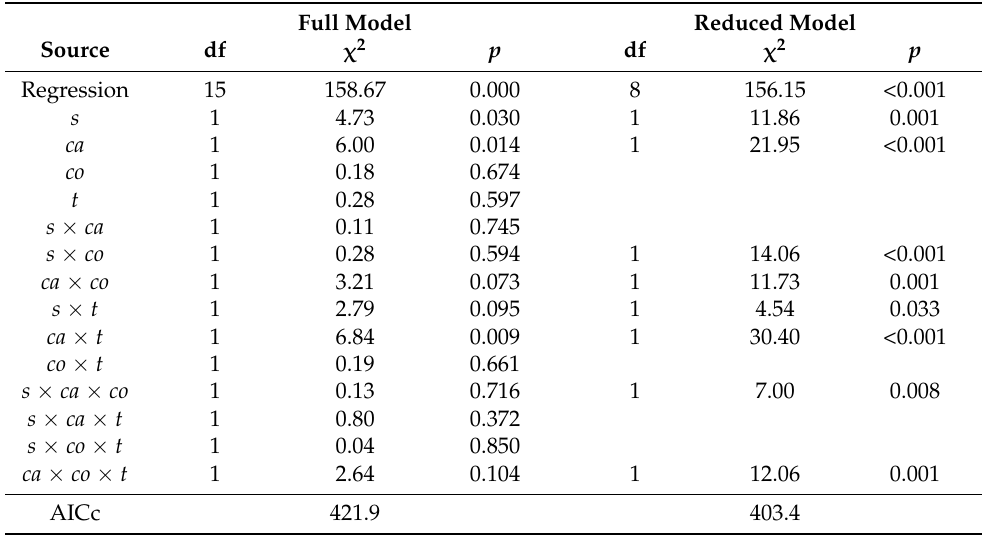
reduced model is Equation